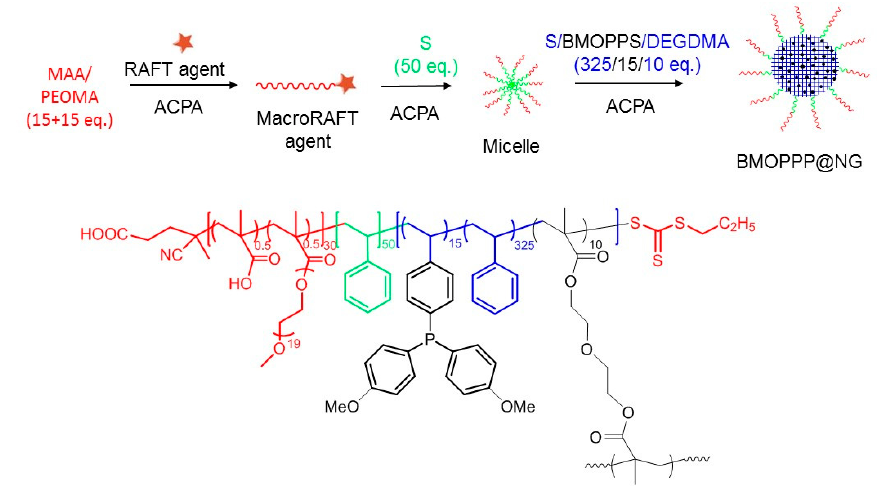
Figure 3. Synthetic scheme and structure of BMOPPP@NG. MAA, methacrylic acid; PEOMA, poly(ethylene oxide) methyl ether methacrylate; ACPA, 4,4 ′ -azobis(4-cyanopentanoic acid); DEGDMA, di(ethylene glycol) dimethacrylate. Table 1. Polymer latexes used in this study a . PDI, polydispersity index; DPPS, 4-(diphenylphosphino)styrene.